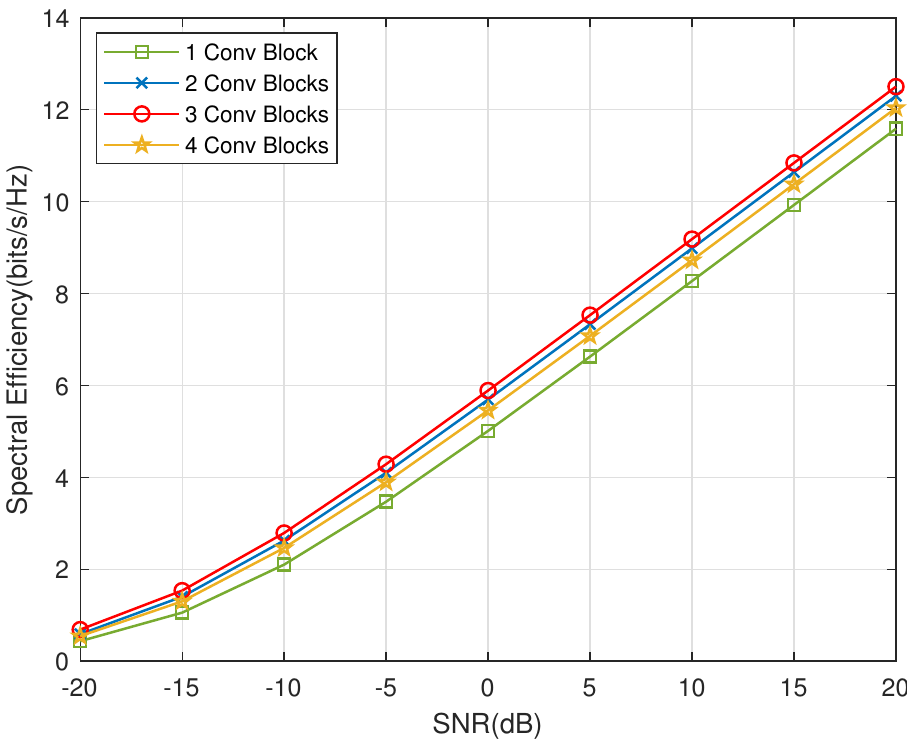
Figure 3. Spectral efficiency comparisons of the proposed scheme under various numbers of Conv blocks in geometric mmWave channel with N t = 64.